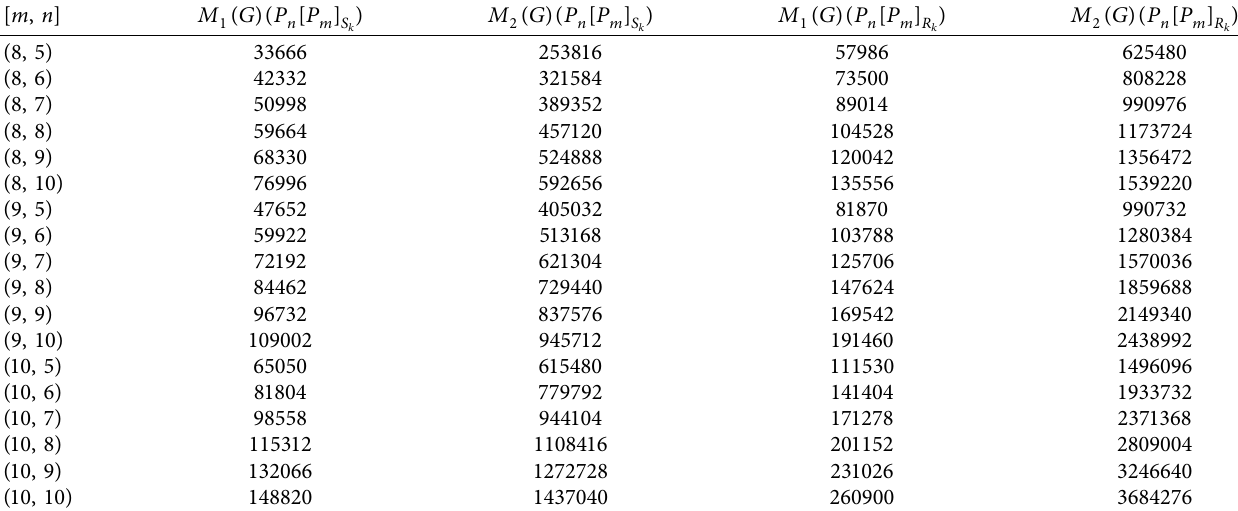
Table 4: Numerical comparison for generalized networks G ( P